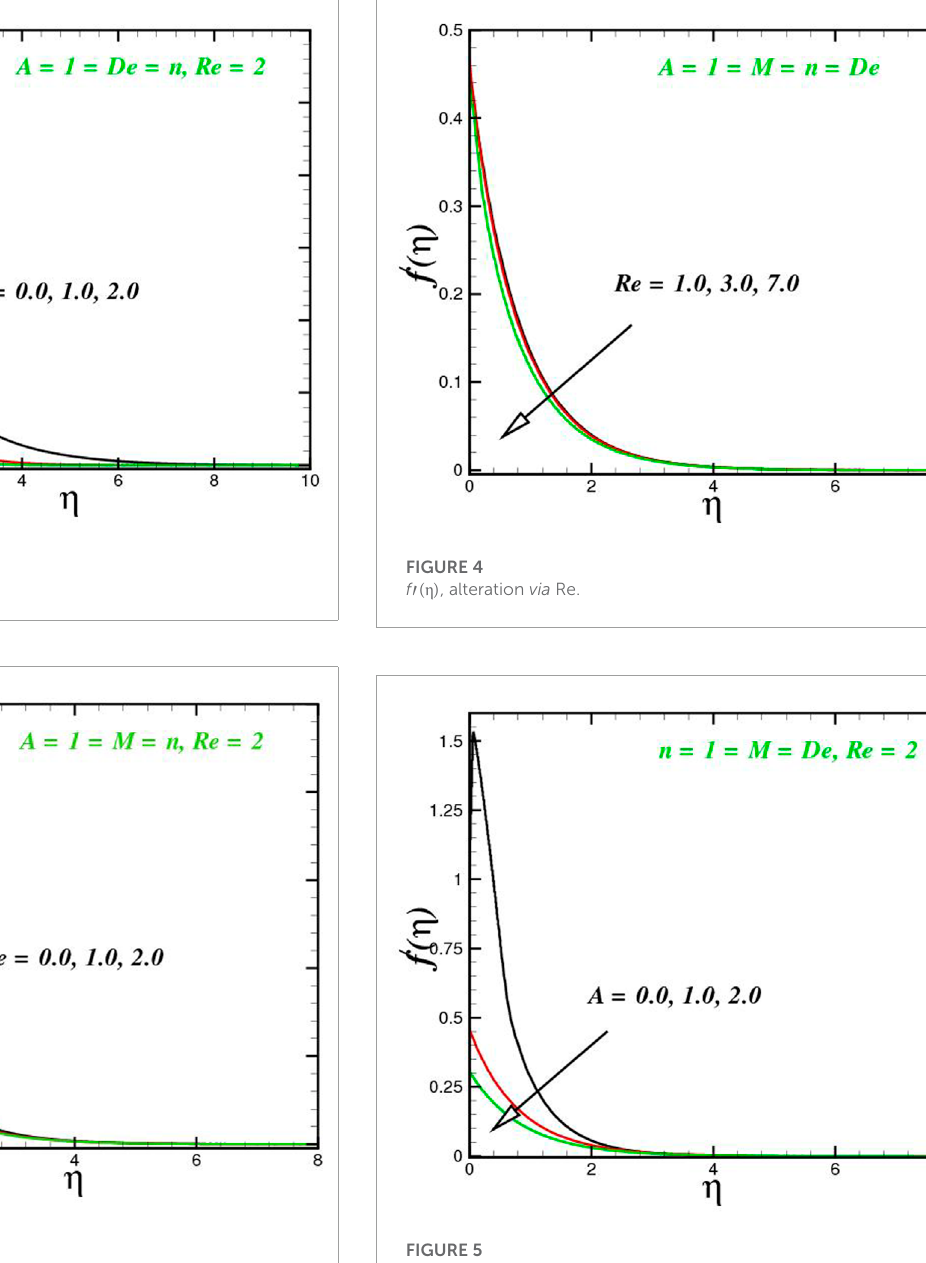
FIGURE 5 f ′( η ) , alteration via